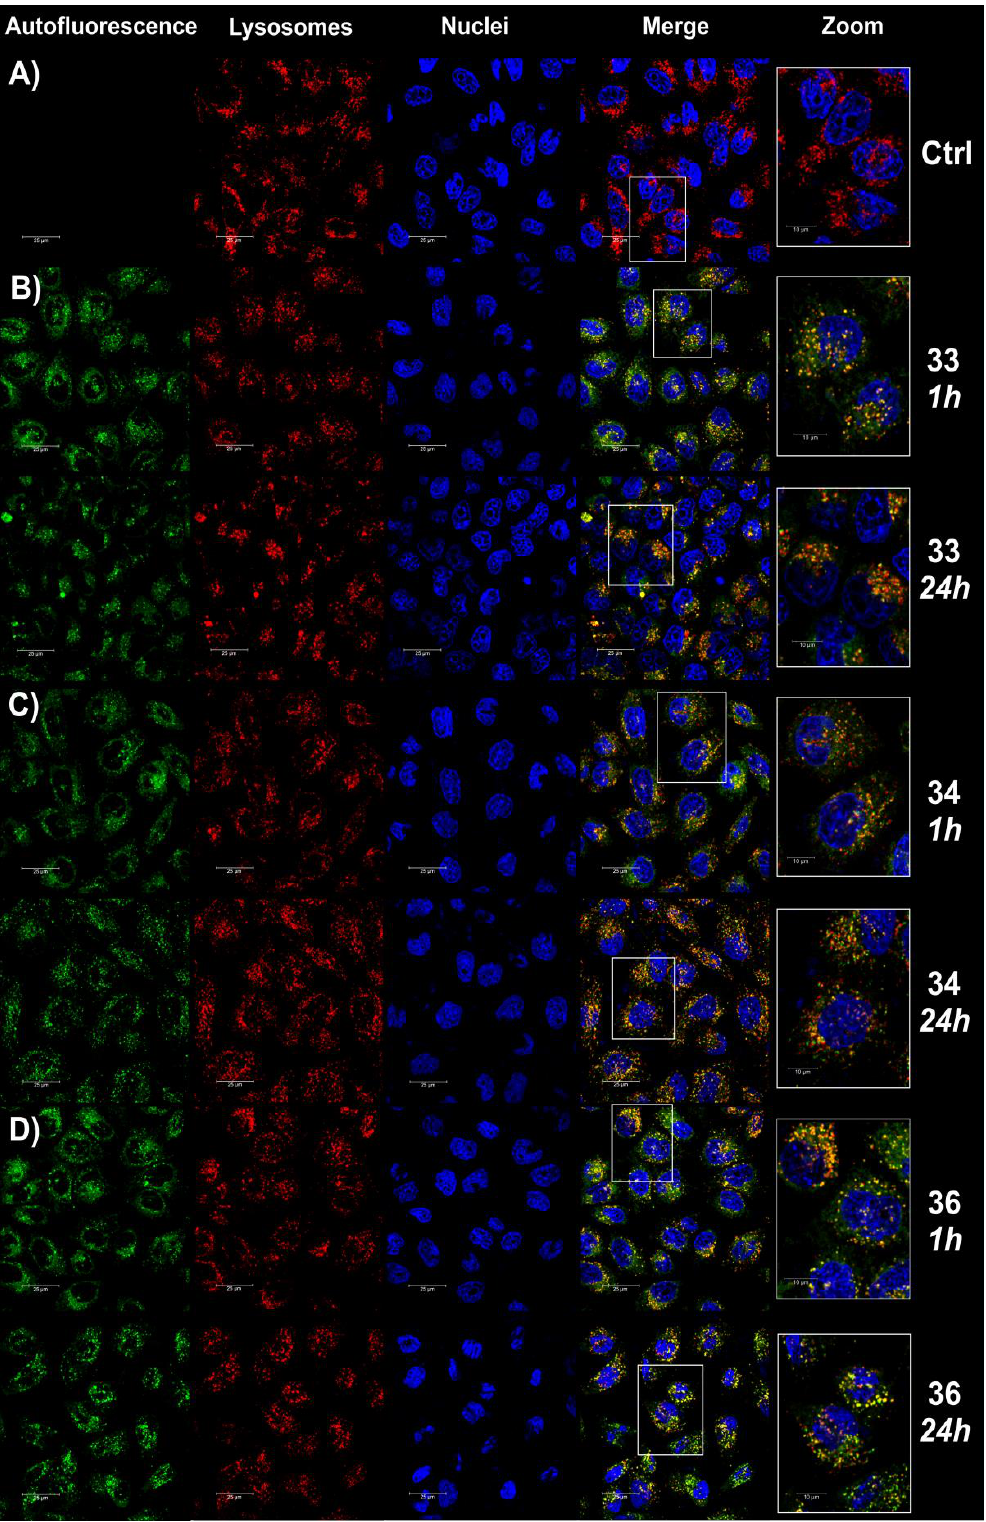
Figure 7. Confocal microscopy analysis of the co-localization of compounds 33 , 34 , and 36 . The analysis was carried out after 1 and 24 h of treatment of the cells with compounds 33 ( B ), 34 ( C ) and 36 ( D ) at the final concentration corresponding to the whole IC 50 values. Untreated cells were used as a control ( A ). Panels with green fluorescence show the autofluorescence of the investigated compounds (Ex/Em 488/500–600 nm), panels with red fluorescence show the autofluorescence of stained lysosomes (Ex/Em 561/585–655 nm), and panels with blue fluorescence present nuclei labeling (Ex/Em 405/430–480 nm). Merged images are shown in the right panels.